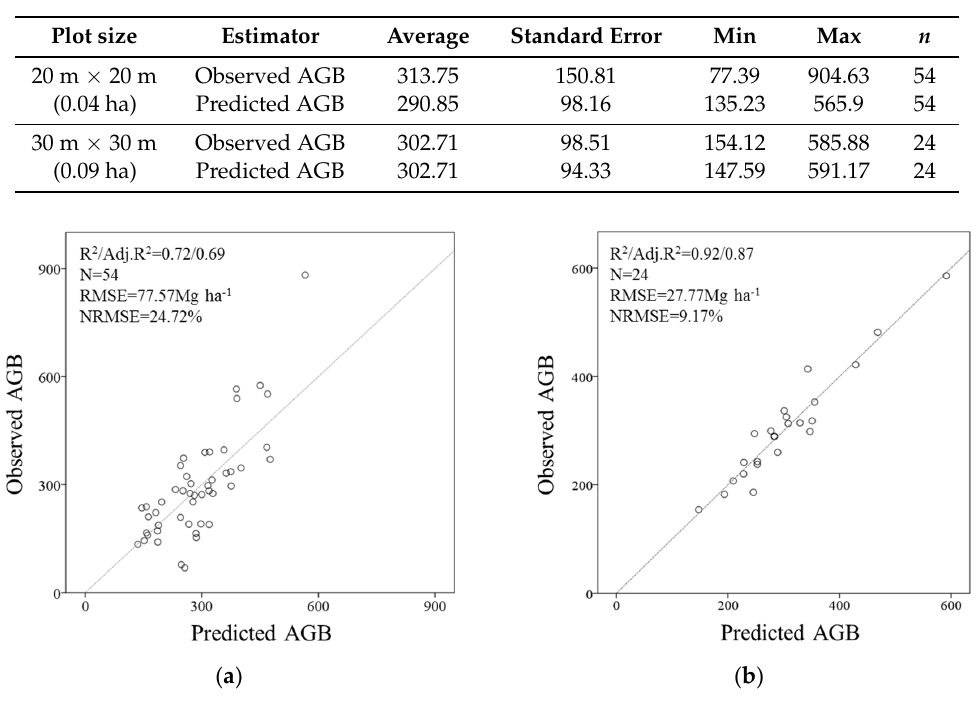
Table 4. Summary of field-measured (observed) above-ground biomass (AGB) and LiDAR-predicted (predicted) AGB (Mg · ha − 1 ) by plot size.